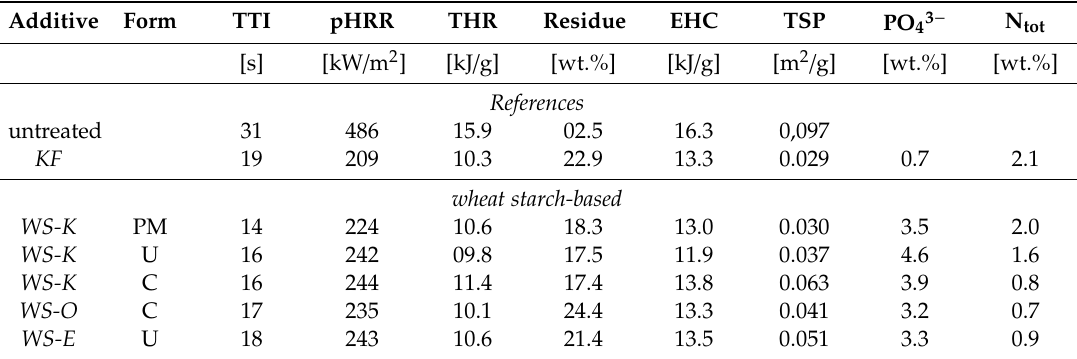
Table 5. Results from cone calorimeter measurements, test matrix wood fiber, additive content 10 wt.%.